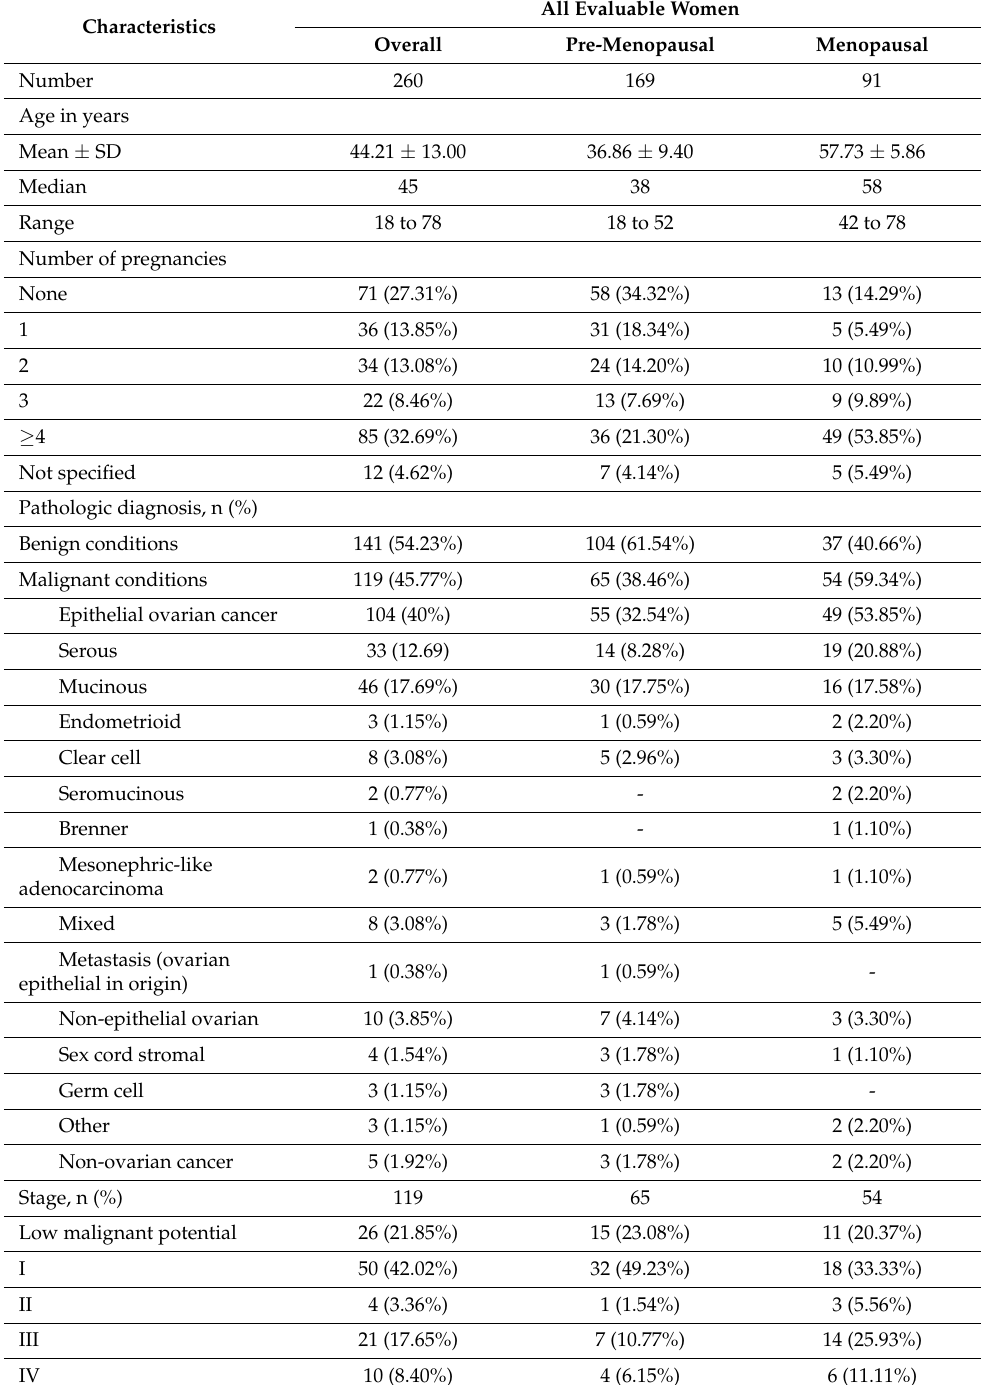
Table 1. Demographic characteristics and pathologic results for the evaluable